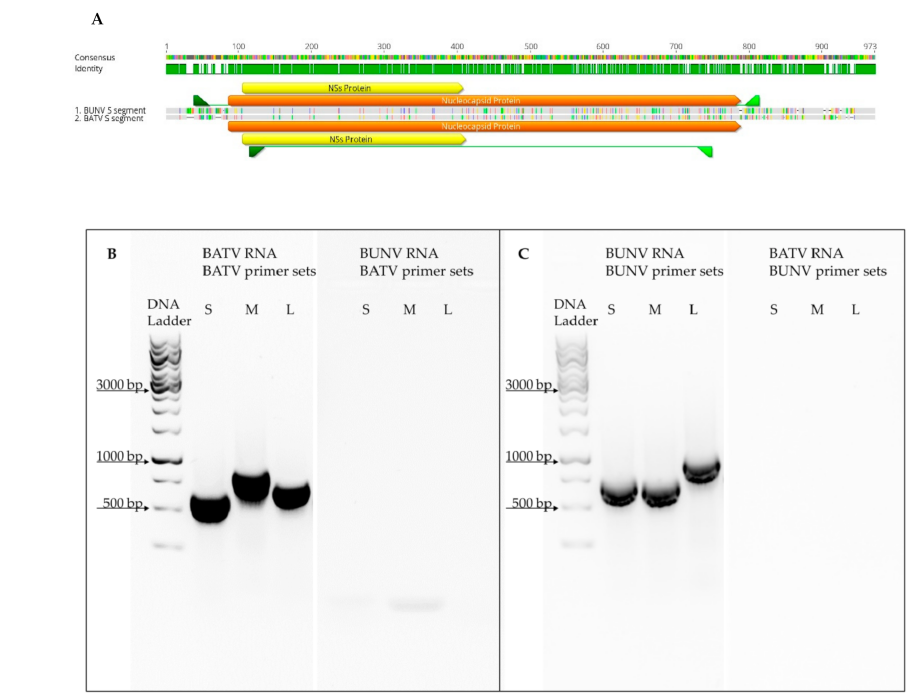
Figure 1. ( A ) Sequence alignment of BATV and BUNV S segments and the primer’s respective placement for unique amplification. Visualisation with Geneious Prime 2021.0.3. ( B , C ) Representative agarose gel runs after amplifying BATV and BUNV L-, M- and S-segments using segment-specific primer sets (Supplementary Table S1). ( B ) BATV primer sets; ( C ) BUNV primer